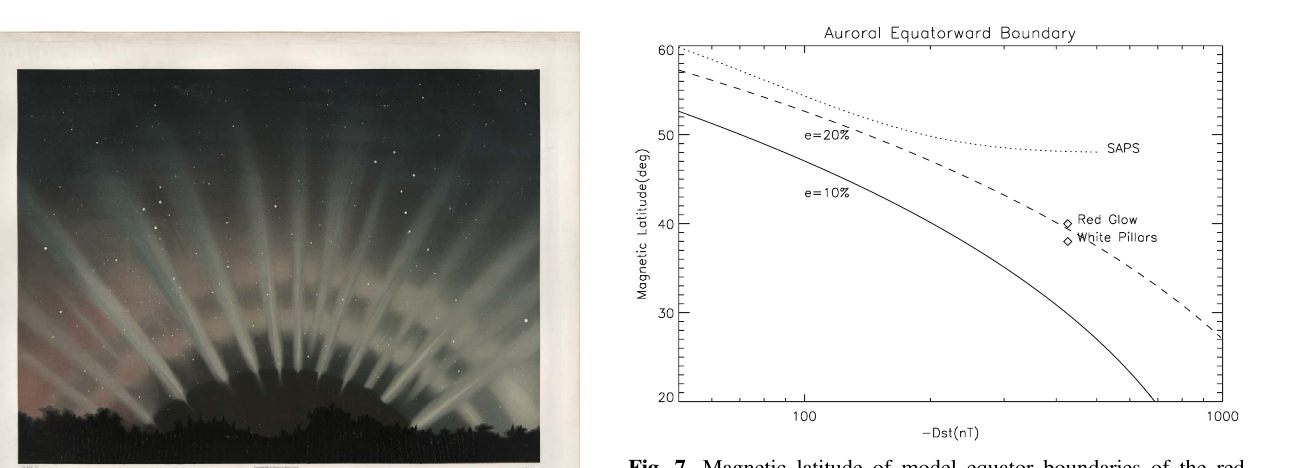
Fig. 7. Magnetic latitude of model equator boundaries of the red aurora (Kataoka & Iwahashi, 2017) and the sub-auroral polarization stream (Wang et al., 2008). Diamonds show the red glow and white pillars of February 11, 1958 event.